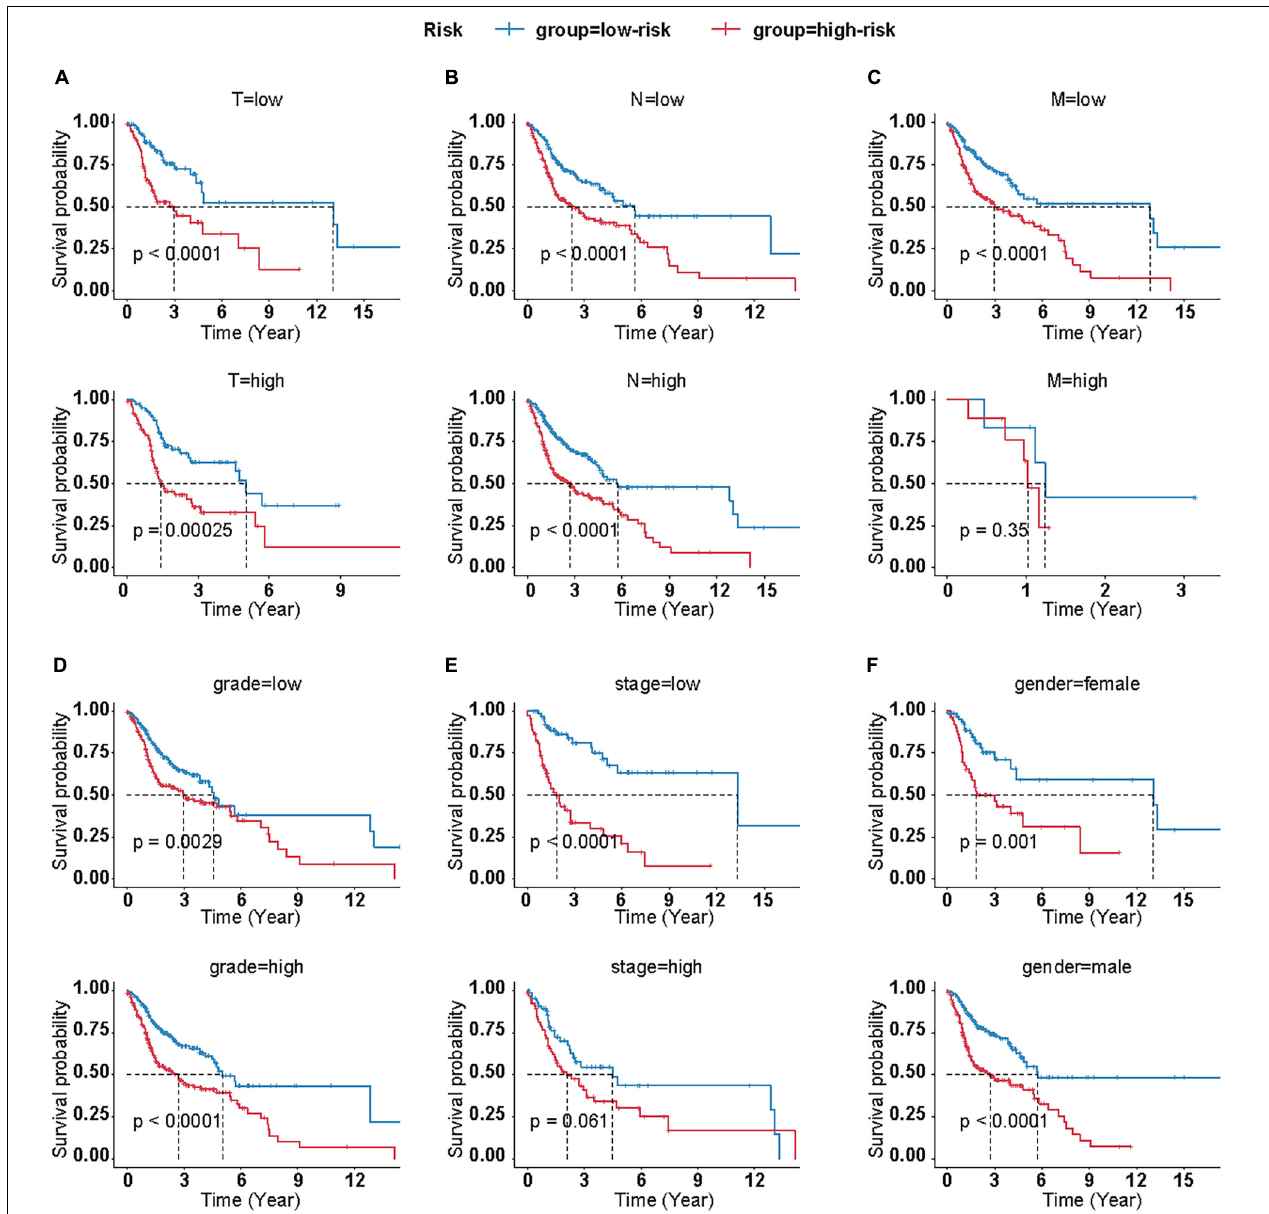
FIGURE 3 | Clinical significance of CMS in different subgroups. Survival analyses of CMS in HNSCC patients with different T (A) , N (B) , M (C) , grade (D) , stage (E) , and gender (F) . (T low = T1+T2; T high = T2+T4; N low = N0+N1; N high = N2+N3+NX; M low = M0; M high = M1+MX; grade low = G1+G2; grade high = G3+G4+GX; stage low = I+II, stage high =